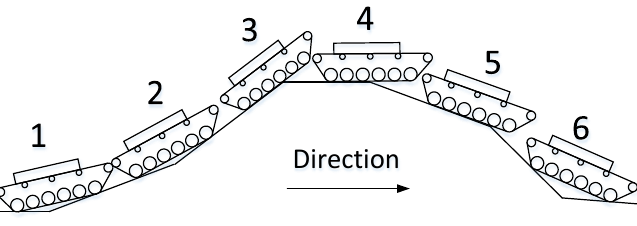
Figure 2. Diagram of a tracked vehicle on a slope.